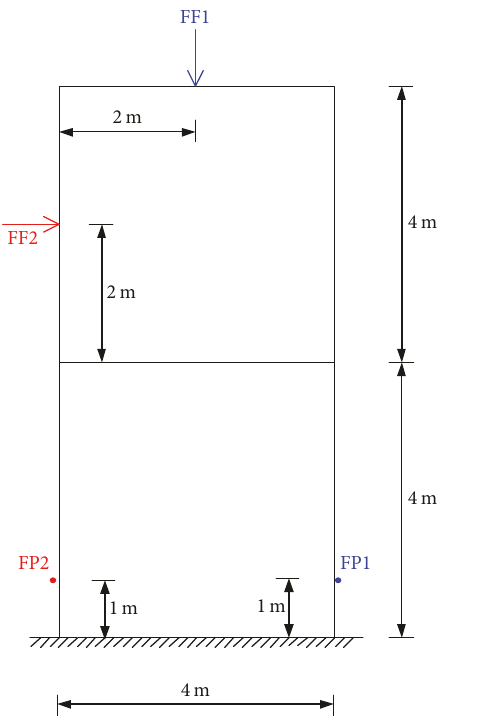
Figure 9: The simulated double-story frame.